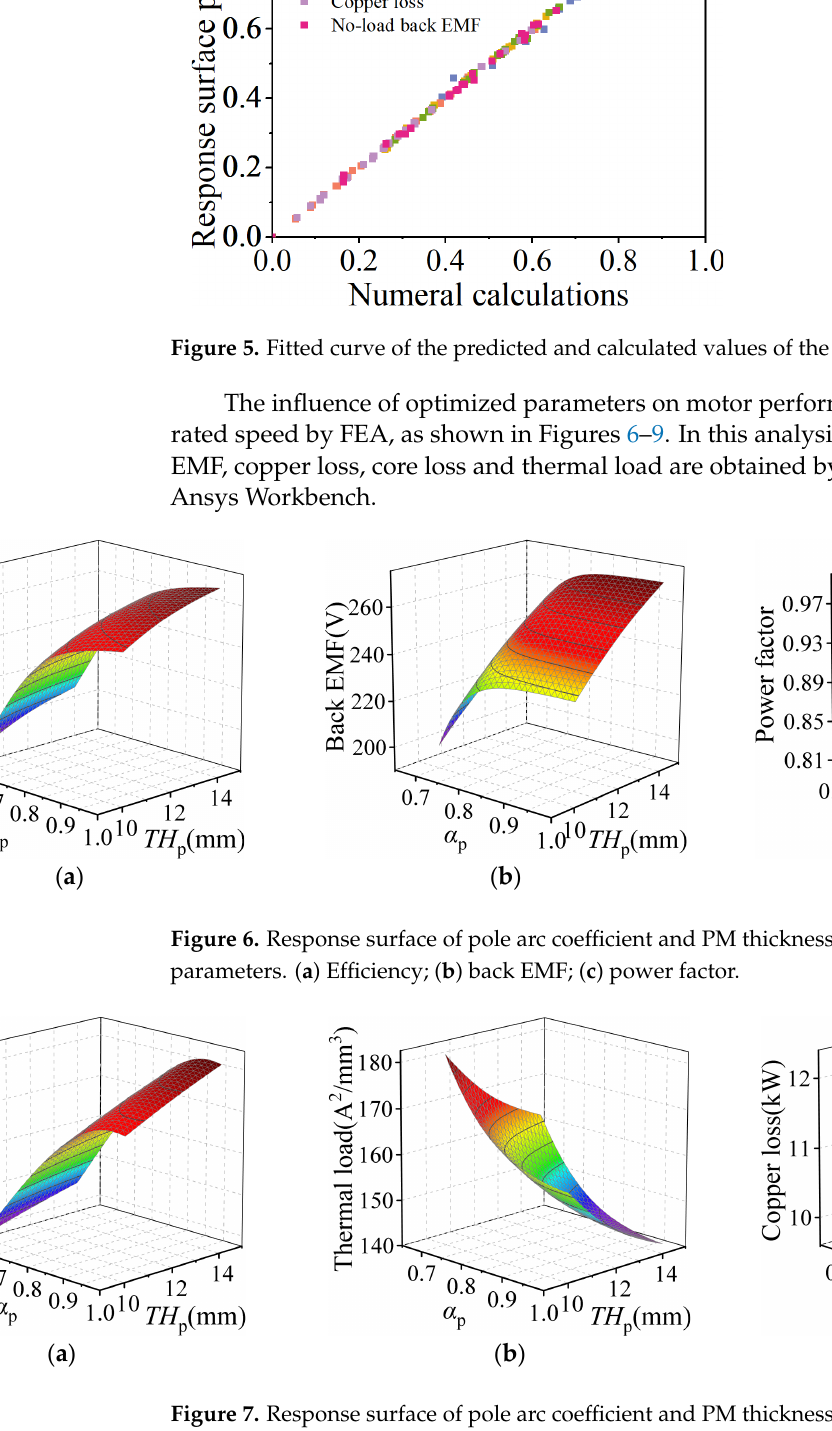
( c ) Figure 8. Response surface of core length and stator outer diameter to electromagnetic performance parameters. ( a ) Efficiency; ( b ) back EMF; ( c ) core loss.